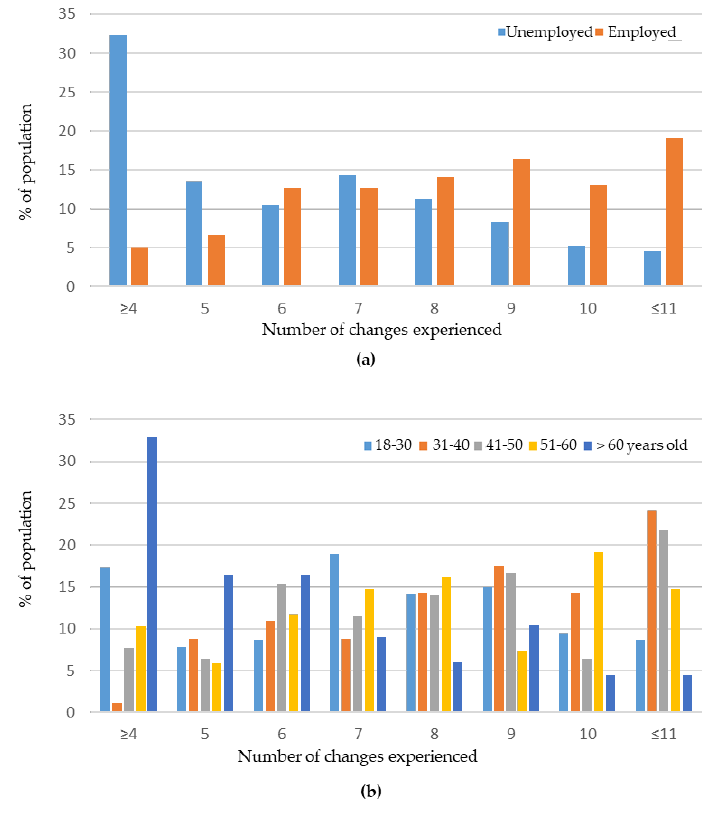
Figure 1. Number of changes observed in the studied population: ( a ) depending on the employment status—the incidence in the employed population is shown in orange, while that in the unemployed one is in blue; and ( b ) depending on the age class—the incidence in the 18–30 age class is shown in clear blue, that for 31–40 is shown in orange, that for 41–50 is shown in grey, that for 51–60 is shown in yellow, and that for respondents more than 61 years old is shown in dark blue.